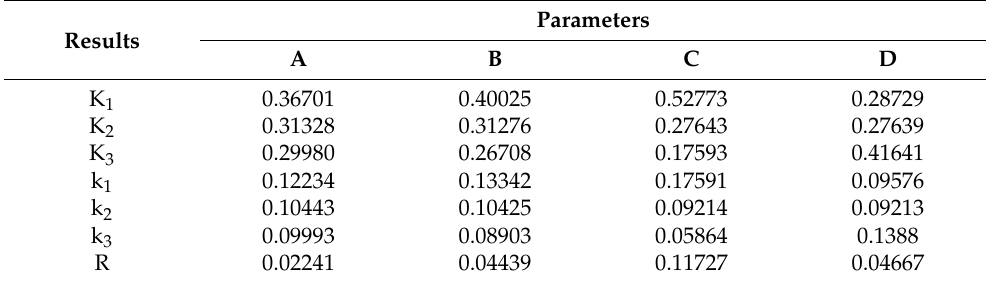
Table 7. The result of range.